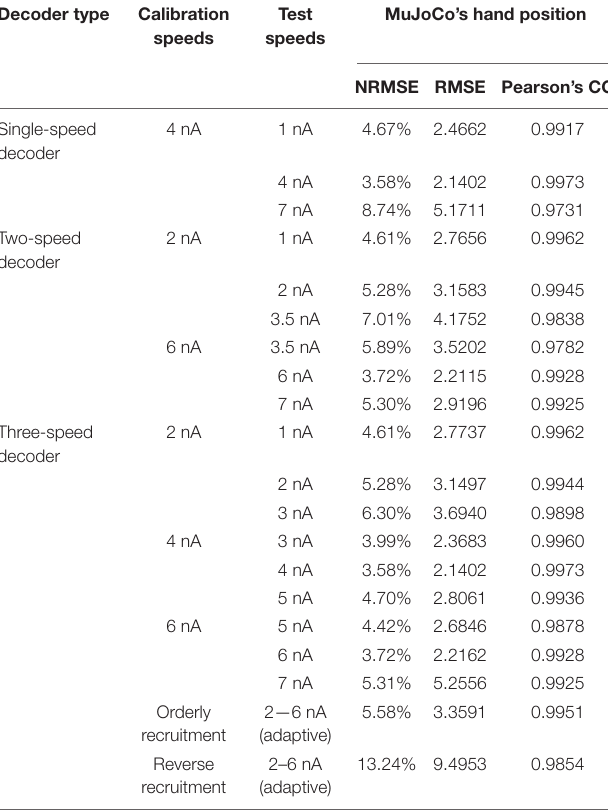
TABLE 2 | Summary of performance measures for the different types of neural decoders. Decoder